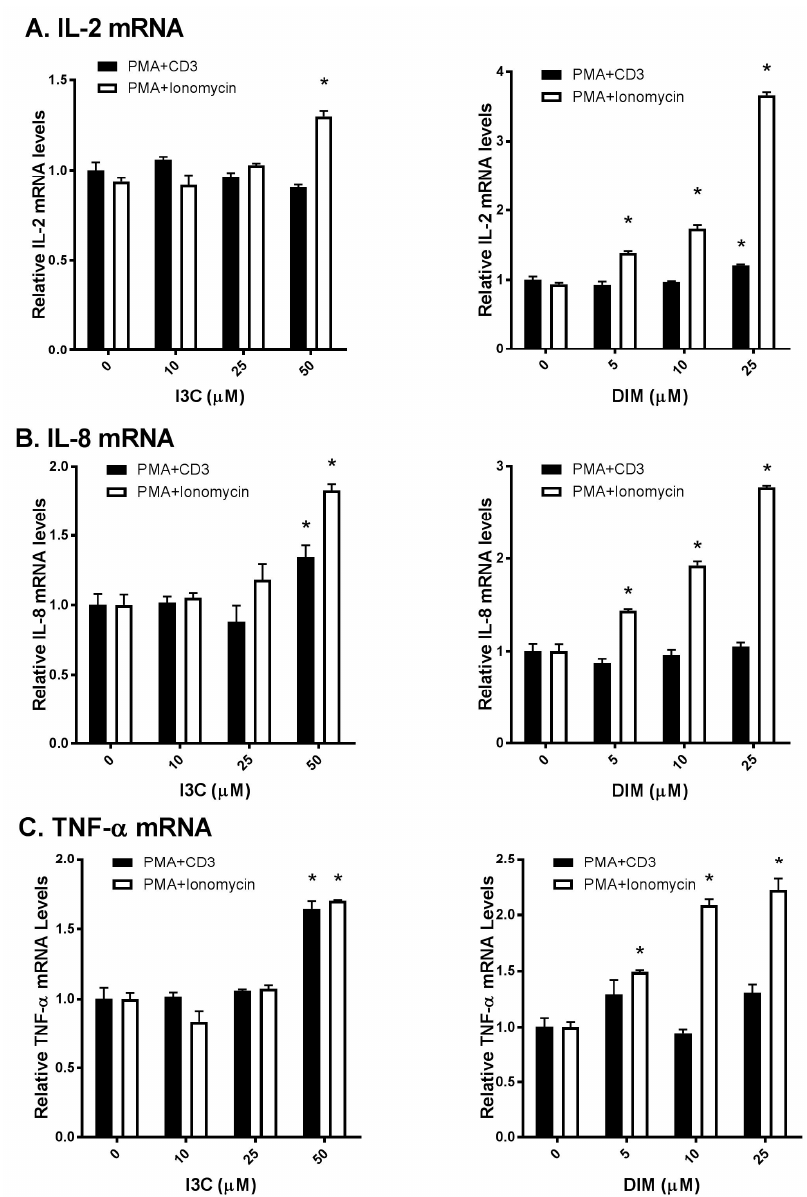
Figure 2. Effects of I3C, DIM on Interleukin-2 (IL-2), Interleukin-8 (IL-8) and Tumor Necrosis Factor- α (TNF- α ) mRNA levels in Jurkat cells. Jurkat cells were treated with 10, 25 or 50 µ M of I3C or 5, 10 or 25 µ M of DIM for 48 h and then stimulated with phorbol-12-myristate-13-acetate (PMA) + anti-cluster of differentiation 3 (CD3) antibody or PMA + ionomycin for 6 h. Genes expression determinations of: ( A ) IL-2; ( B ) IL-8; and ( C ) TNF- α were analyzed using real time polymerase chain reaction (RT-PCR). Results expressed as mean ± SD ( n = 3) from three independent experiments. * indicates significantly different from control at p < 0.05 (Two-Way Anova).